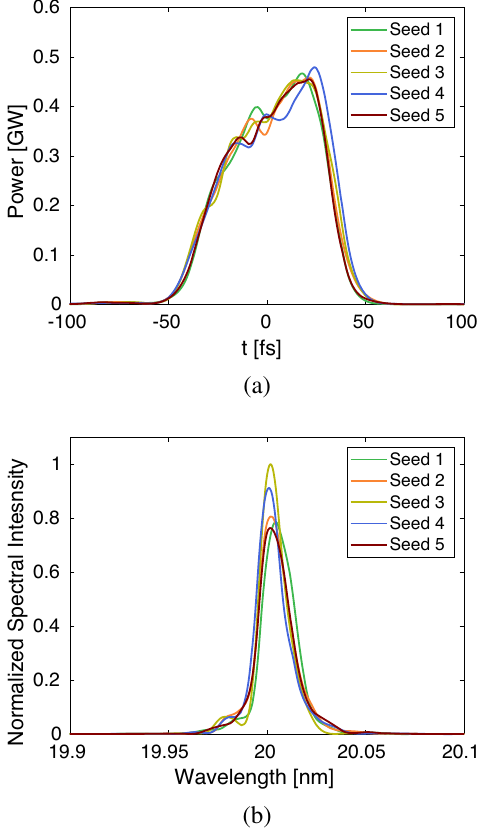
FIG. 8. Shot-to-shot fluctuations for a standard HGHG setup, imprinted on the output FEL at 20 nm. (a) Power profile for different initial shot noise. (b) Spectra for different initial shot noise. They are normalized to the highest spectral intensity with Seed 2.